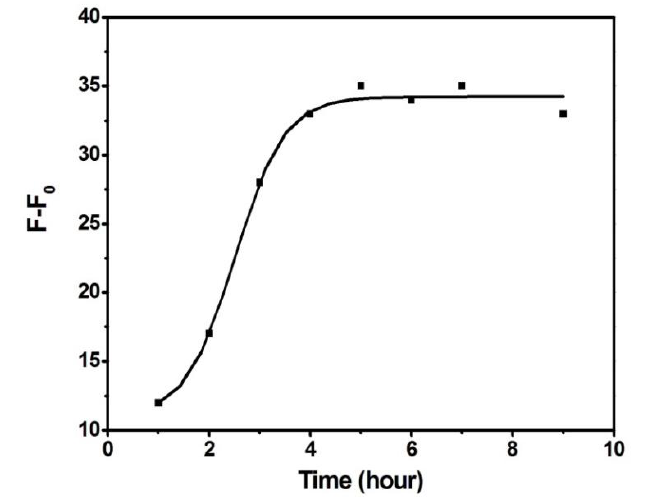
Figure 5. The fluorescence recovery (F-F of 60 nM